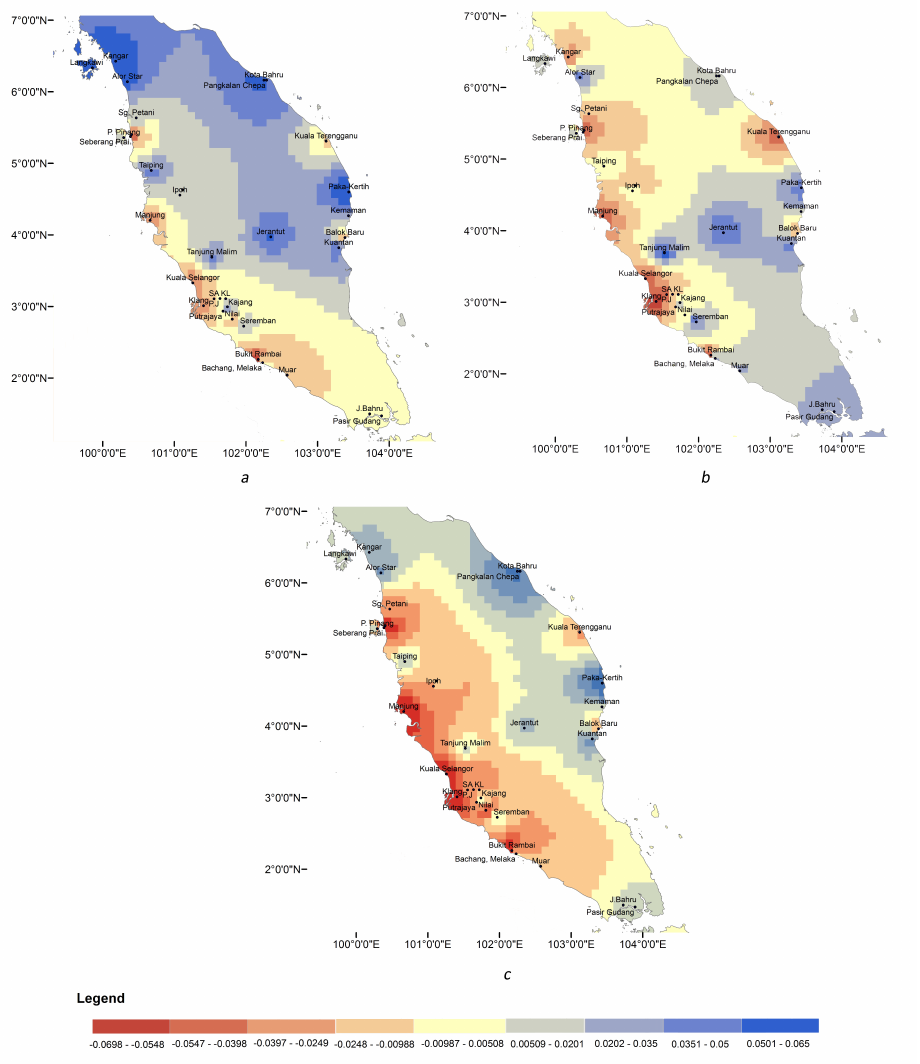
Fig. 2. Seasonal distribution of random error (a) intermonsoon, (b) northeast monsoon, (c) southwest monsoon